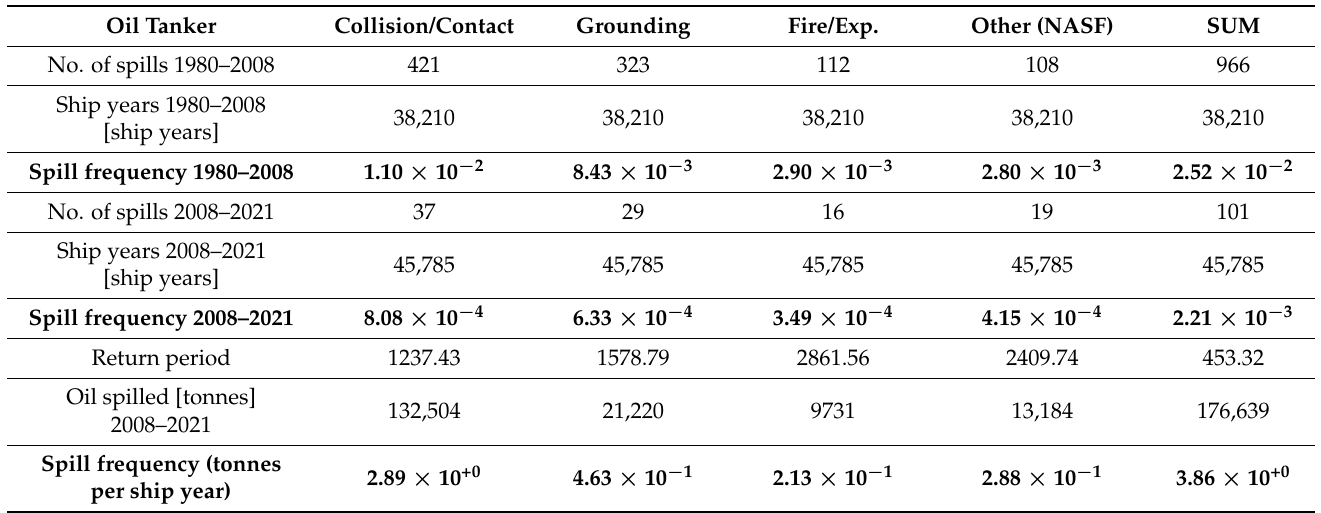
Table 2. Oil spill frequency calculated for